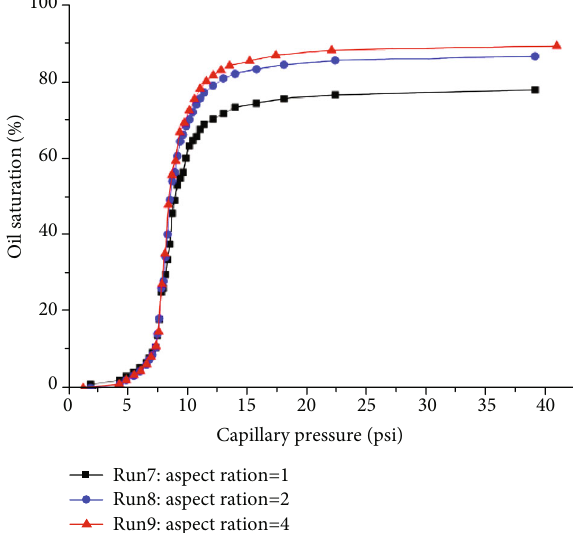
Figure 12: E ff ect of brine viscosity on oil charging